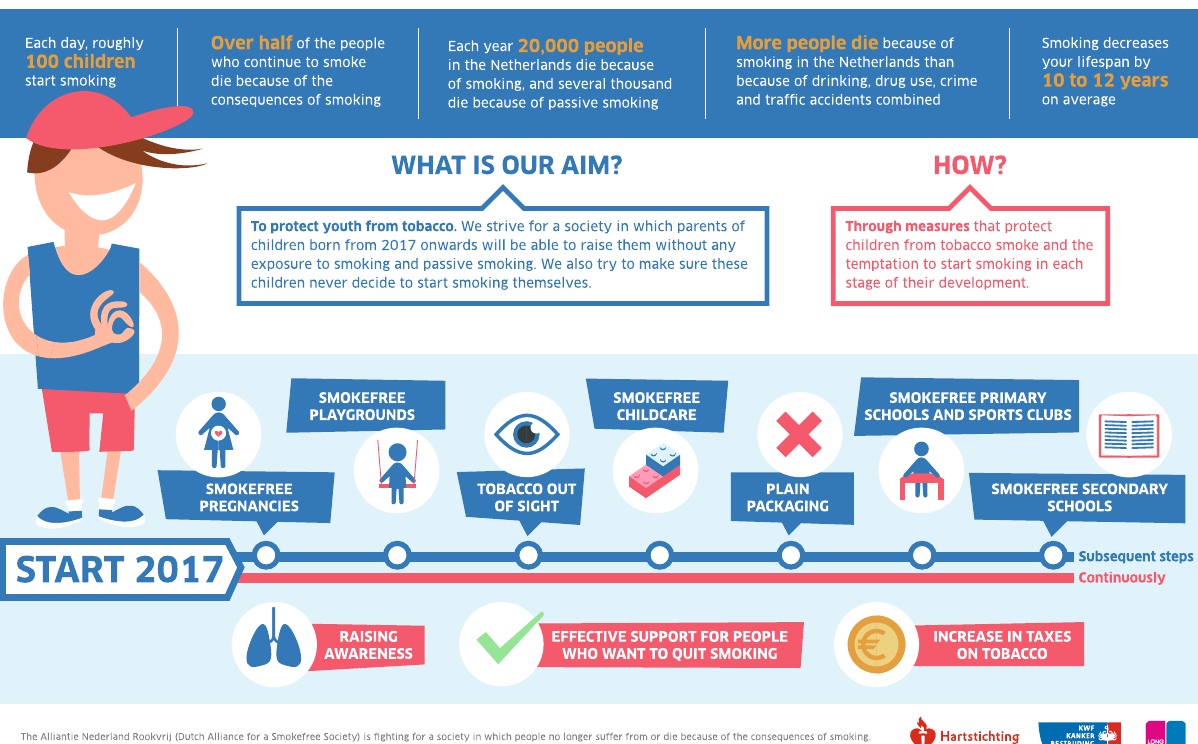
Fig. 1 Roadmap towards a Smoke-free Generation in the Netherlands. Infographic developed by Dutch Alliance for a Smokefree Society, currently ‘ Health Funds for Smoke-free ’ ( Gezondheidsfondsen voor Rookvrij ; GvRV); reprinted with permission.